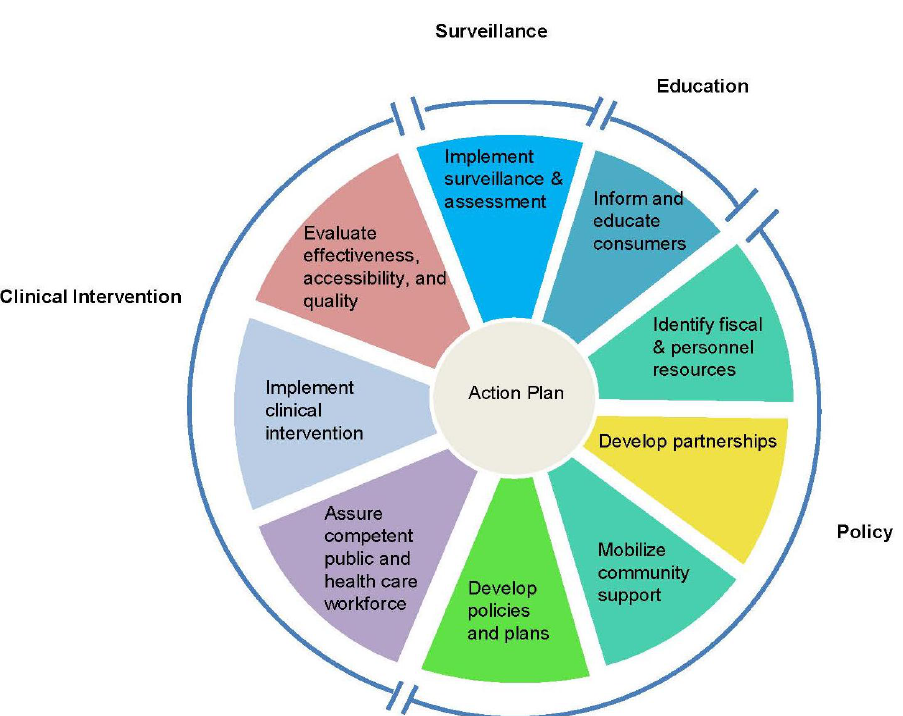
Figure 1. Process used.